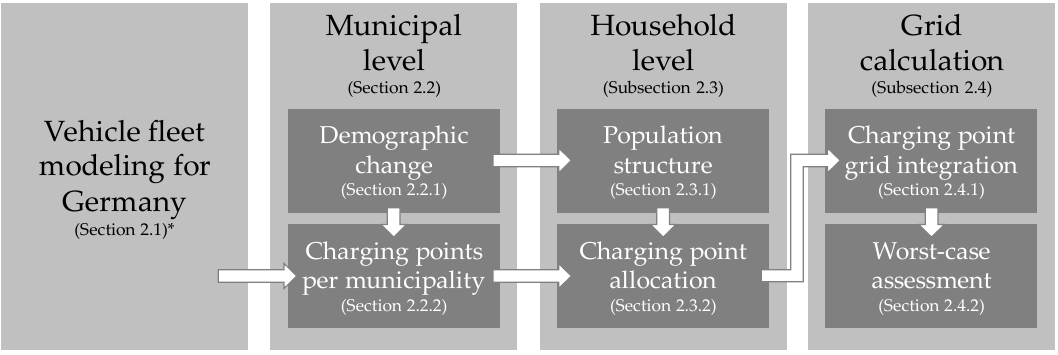
Figure 1. Overview of the structure of our model, with references to the corresponding sections in this paper.